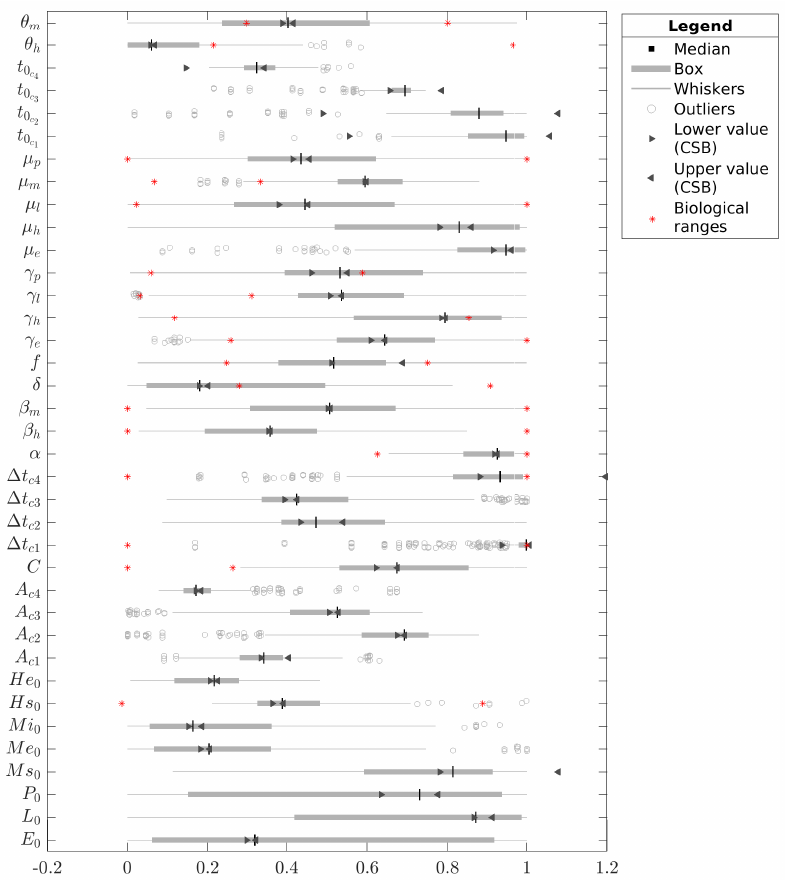
Figure 4. Boxplot for all parameters estimated with the four pulse-type inputs model (Case C). The boxes and whiskers are filtered estimations that define the medians (nominal value), and the red stars represent the biological intervals identified in the literature. All values are normalized according to the minimum and maximum values of the estimation intervals proposed in Table